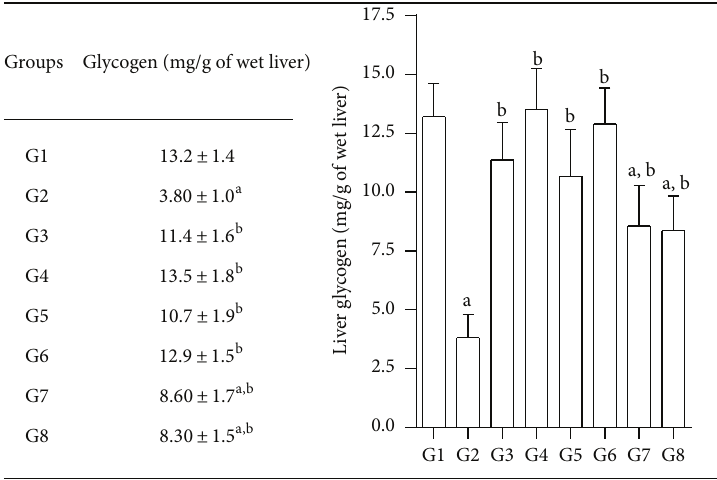
Figure 8: Effects of test compounds on liver glycogen levels in nicotinamide, STZ diabetic rats; values are in mg/g of wet liver ( mean ± SEM ) ;